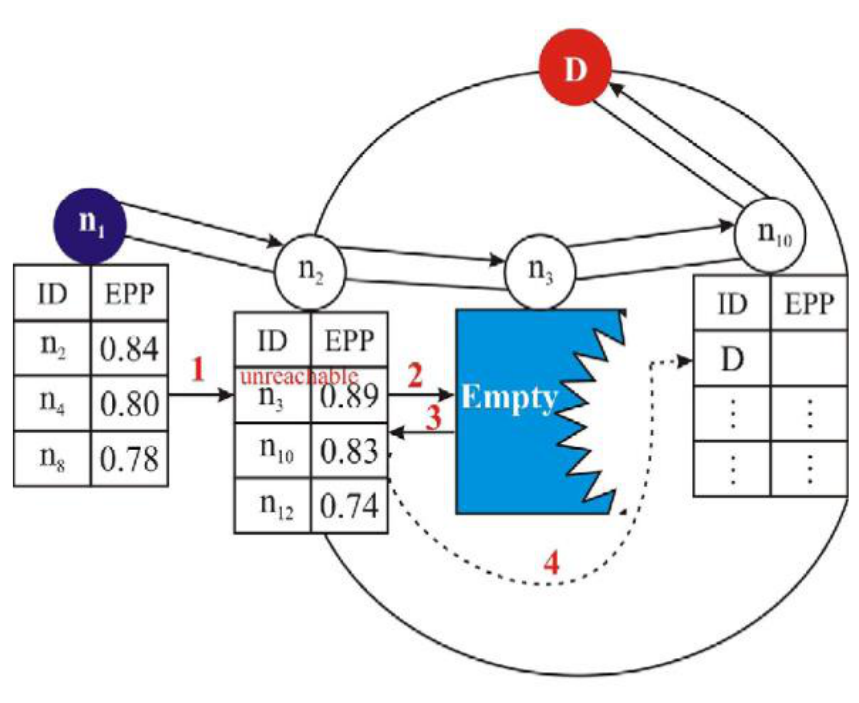
Figure 9. VHGOR recovery mode [48].